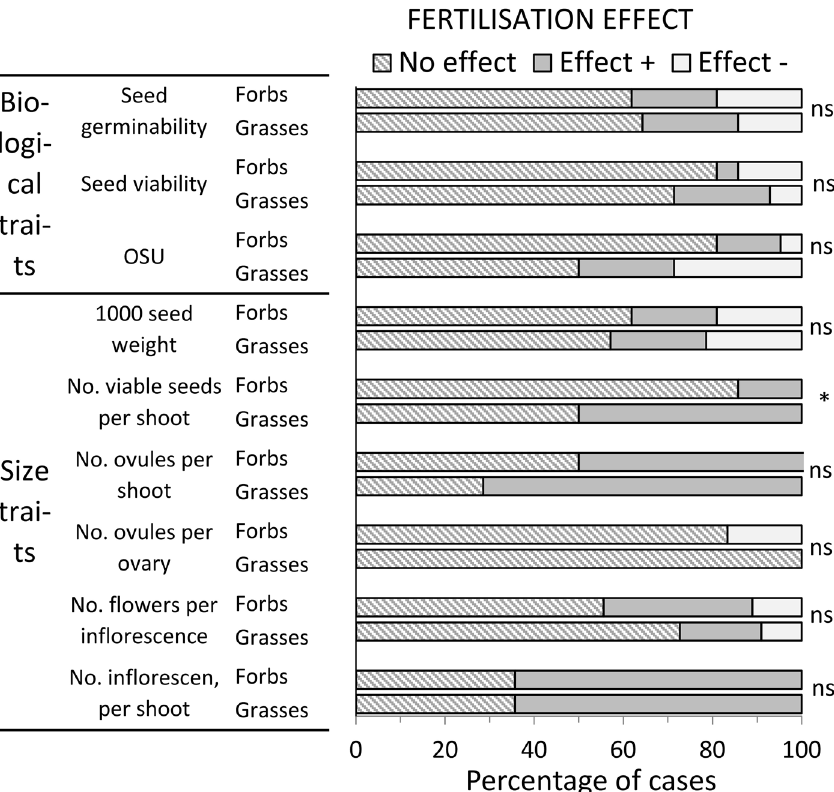
Figure 1. Frequency of different effects of fertilisation on the reproductive traits of fifteen grasses and seventeen forbs in a grassland fertilisation trial in the Italian eastern Alps. No effect, Effect + , and effect—denote statistical not significant, and positive or negative effects, respectively. ns and *indicate no significance or significance at p ≤ 0.05 of the chi-square test for the association between species group (grasses and forbs) and type of fertilisation